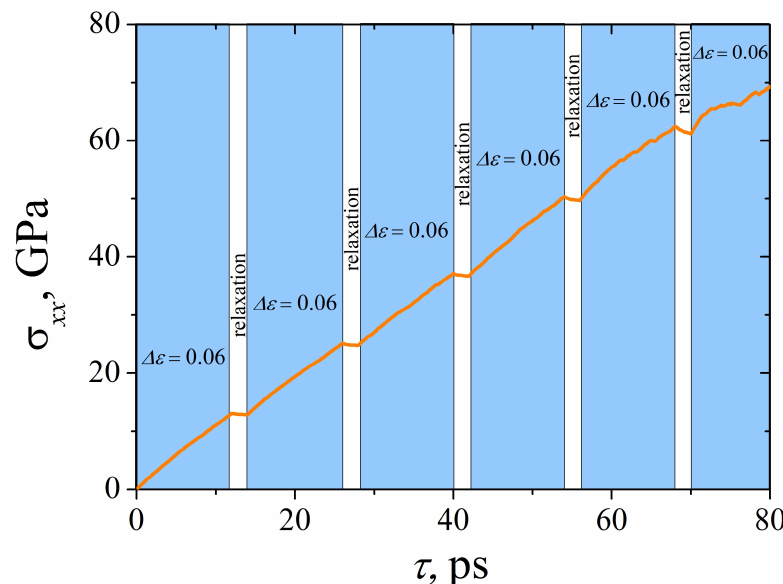
Figure 2. Stress as the function of time for a Ni/graphene composite under uniaxial incremental tension at 0 K and a strain rate of 5 × 10 − 3 ps − 1 . The term “relaxation” means exposure of the structure conserving the volume of the simulation cell for 2 ps (colored white). The areas, when uniaxial tension is applied, are colored